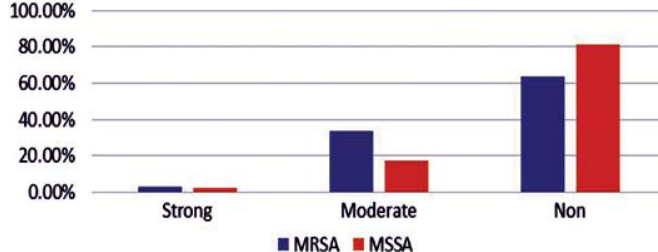
Fig. 3. Biofilm distribution in MRSA and MSSA